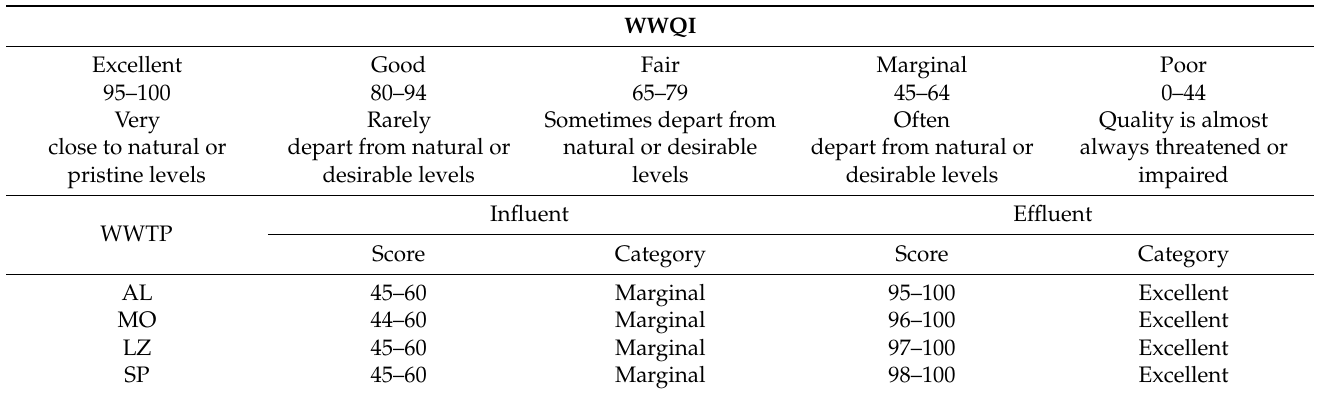
Table 2. WWQI classification and wastewater quality